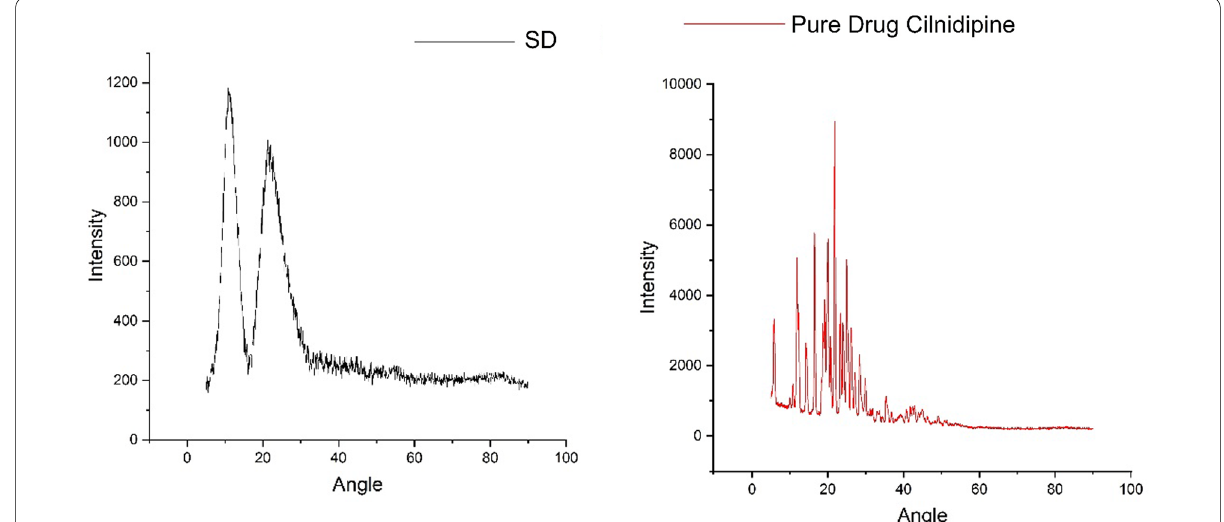
Fig. 5 XRD pattern of solid dispersion and pure cilnidipine. The presence of sharp peaks in cilnidipine indicates the crystalline nature and the scattered lines in the solid dispersion indicate the amorphous